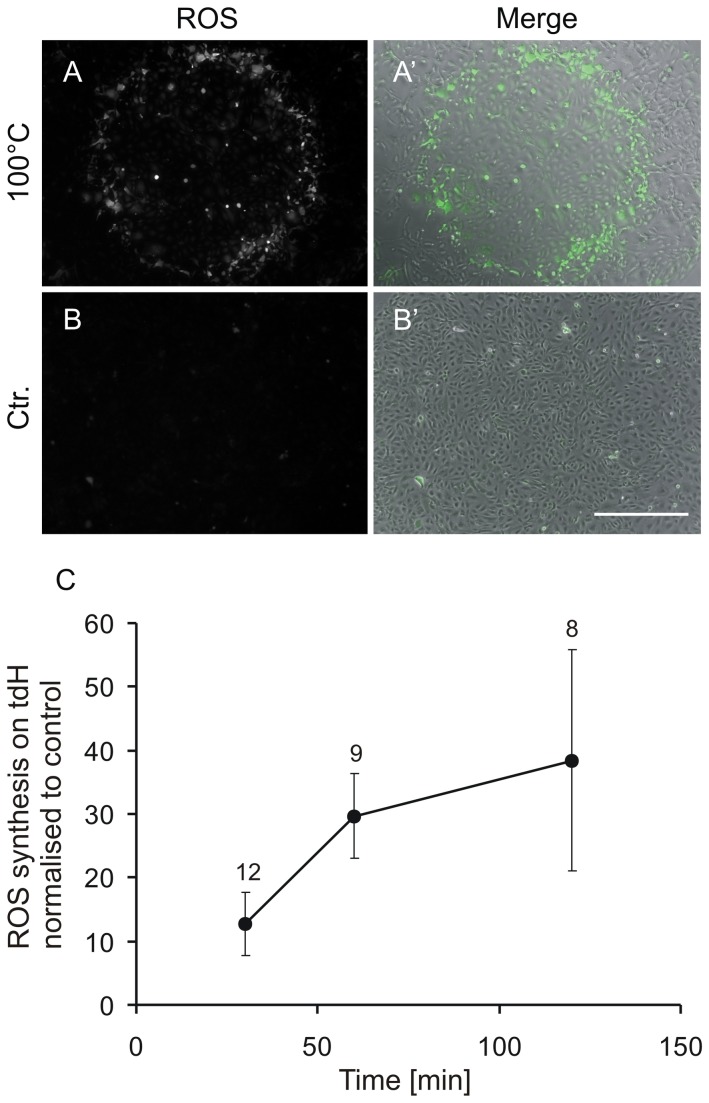
ROS synthesis at the area adjacent to thermally damaged HUVEC (tdH).To detect ROS, the fluorochrome H2DCFDA was used: the intensity of the green fluorescent signal of the region limited by the inner ring was analysed. Representative images of ROS synthesis 30 min after thermal (A, A’) and after mechanical (B, B’) damage. A and B, green fluorescent ROS, merge of HUVEC (phase contrast) and green fluorescent ROS (‘). No ROS synthesis was detected after using the unheated stamp (B). Scale bar 500µm. C: quantification of the ROS synthesis normalised to the control. After 30 min, a 10-fold increase after thermal damage in HUVEC was observed compared to the unheated stamp control, and a 30-fold increase was observed after 1 h. Two hours after thermal damage the signal varied substantially, as is indicated by the error bar. The experiment was performed in triplicates, n>8 images were analysed.